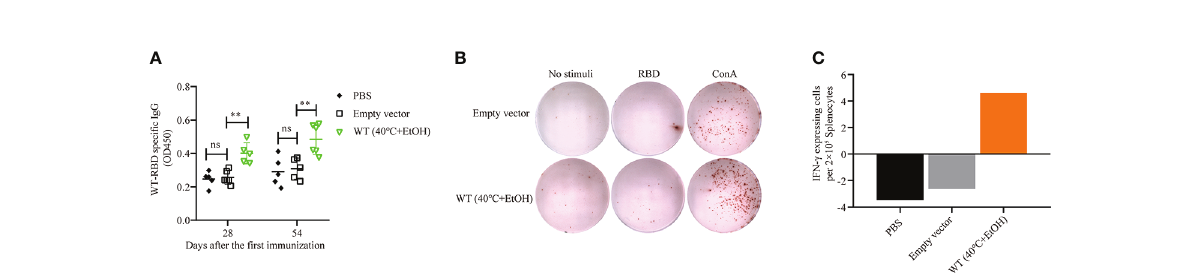
FIGURE 6 Humoral and cellular immune responses of pYD1-RBD (wild-type)/EBY200 recombinant yeast cells inactivated with 25% ethanol at 40°C. Female BALB/c mice were subcutaneously immunized with recombinant yeast or PBS on days 1, 15, and 31. (A) Plasma samples collected on days 28 and 54 after initial immunization were used to determine the levels of RBD-speci fi c IgG by ELISA. Data points represent individual animals. (B) Blood samples were collected on day 54 after initial immunization, and samples from the same group were pooled. Aliquots of 2 × 10 5 PBMCs isolated from each pooled blood sample were stimulated with SARS-CoV-2 S-RBD antigen, concanavalin A (Con A), or medium only. IFN- g -expressing cells were counted. Each dot represents a single cell that secretes IFN- g . (C) Quanti fi cation of the number of IFN- g - expressing cells per 2 × 10 5 PBMCs. PBMC: peripheral blood mononuclear cell. For statistical analysis, t -test was performed to compare empty vector and PBS groups. Asterisks represent signi fi cance: ** p < 0.01; n = 6, ns, no signi fi